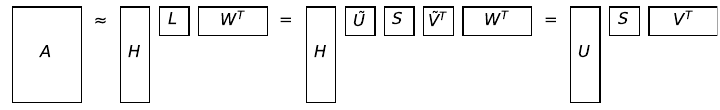
Figure 5. Visualizing the calculation of an approximate SVD via dimensionality